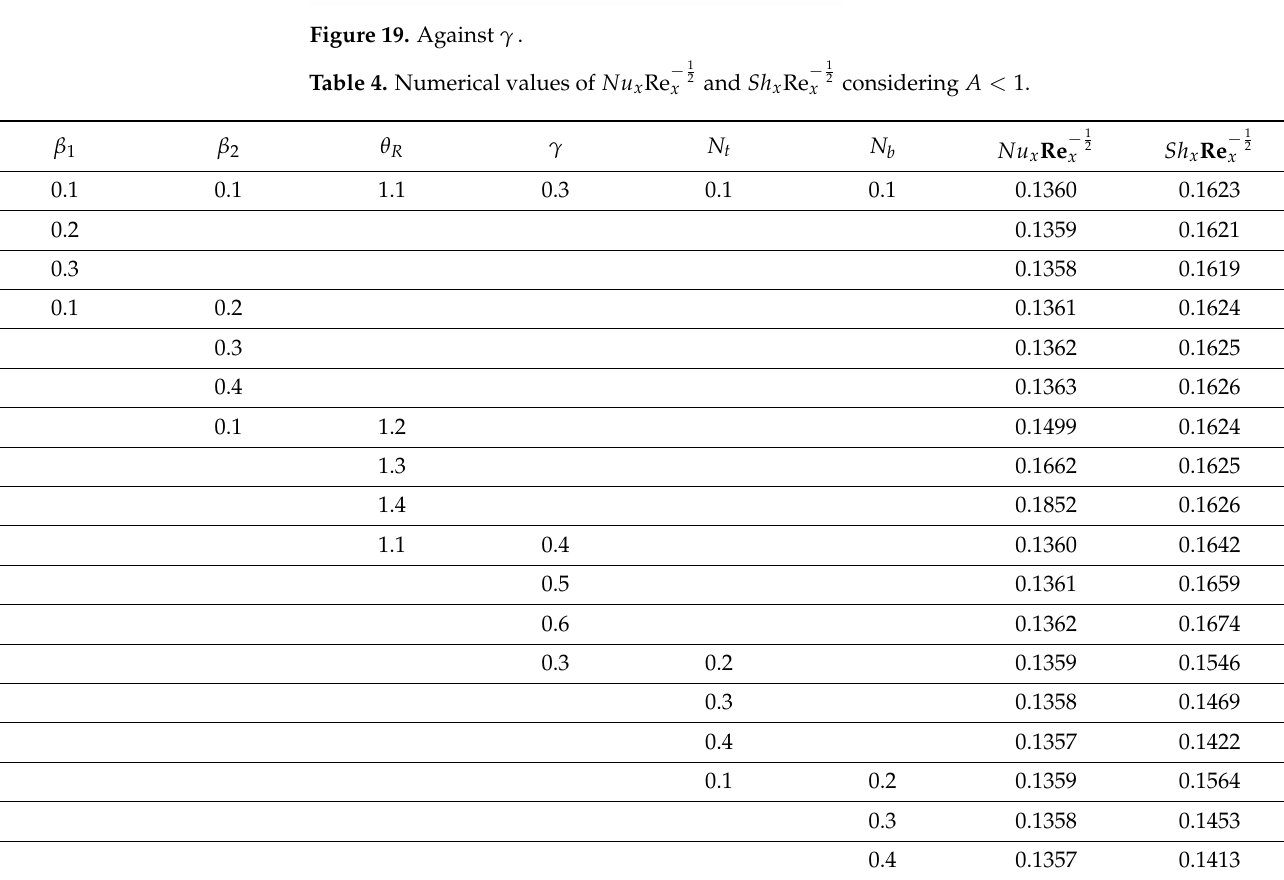
− 1 − 1 2 x and Sh x Re 2 x considering A <